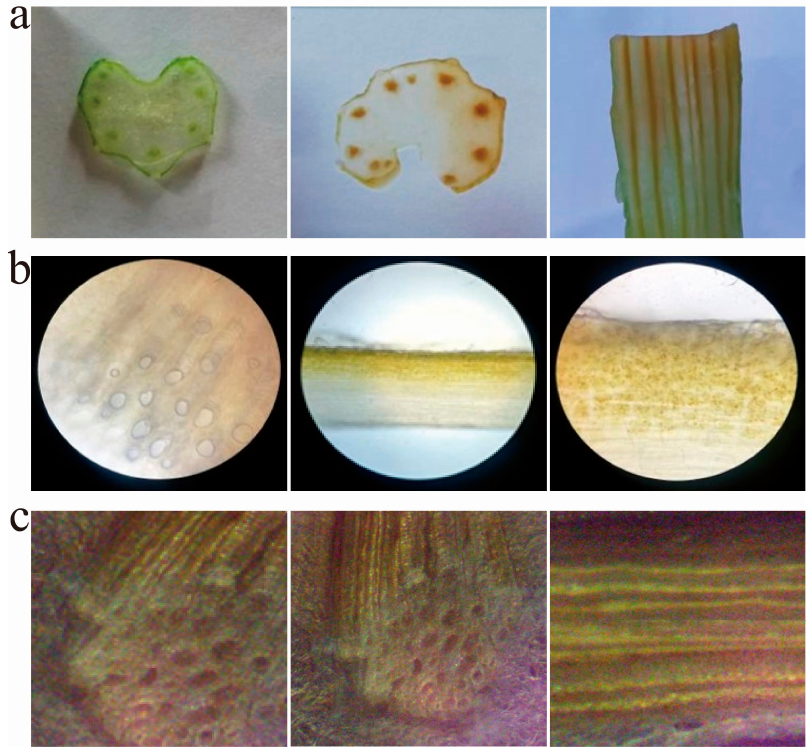
Figure 6. Stems of celery soaked in a long afterglow material solution. Photographs of transverse and longitudinal sections ( a ), microscopic images in daylight ( b ), and microscopic images of vascular bundles after immediate cessation of excitation by UV light ( c